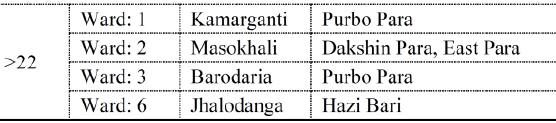
Table 3. Suitable area for arsenic-safe tubewell installation in the study